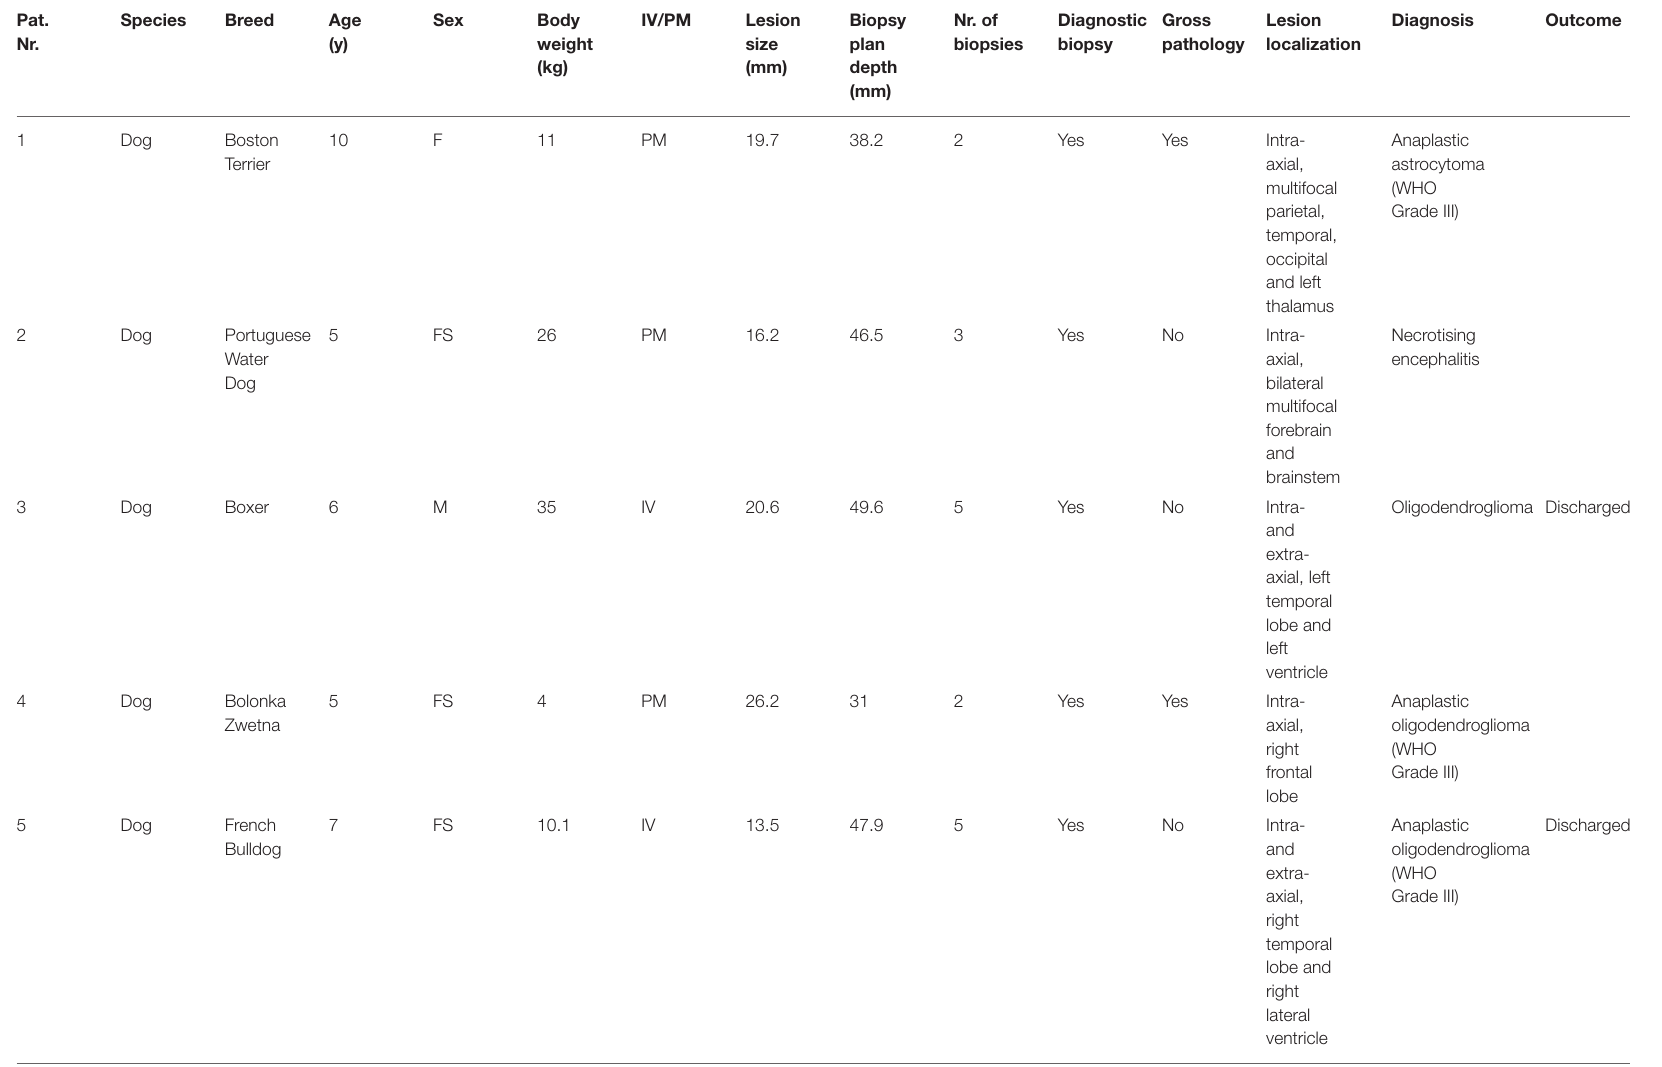
TABLE 1 | Signalment, biopsy characteristics, lesion localization, histopathological diagnosis, and outcome. Pat.